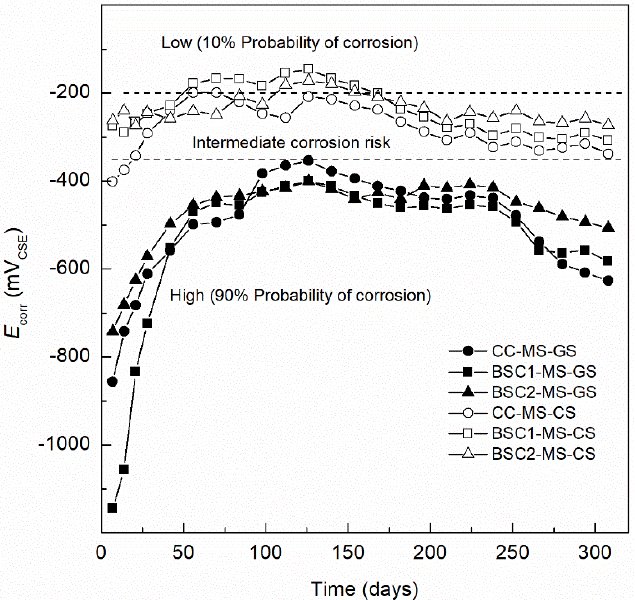
Figure 5. E corr monitoring of GS and CS reinforced concrete exposed to 3.5 wt.% MgSO 4 solution.